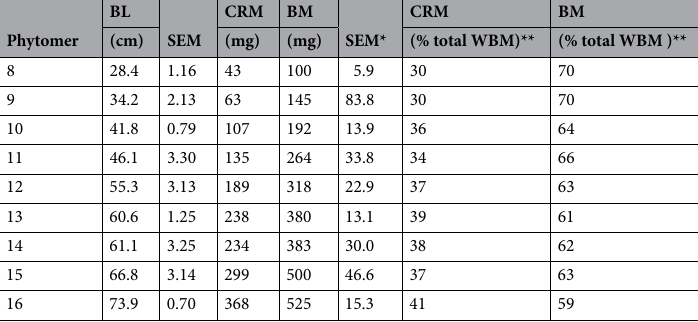
Table 1. Final blade length and blade and central rib mass of Napier elephant grass leaves. BL blade length; SEM standard error of the mean; CRM central rib mass; BM blade mass; *Standard error of the mean for CRM and BM. **Percentage of the whole leaf blade mass (WBM).